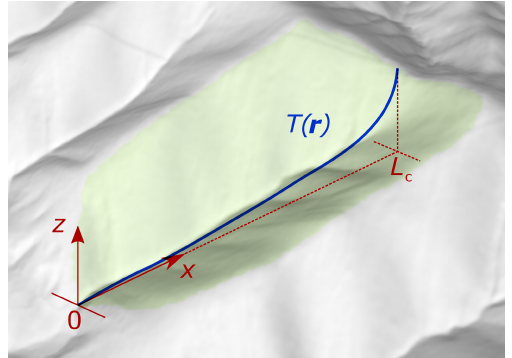
Figure 2. Model context and geometry. Theoretical treatment in the current study is limited to 2D. The model domain is a vertical tran- sect following a stream profile, with vertical axis z and horizontal axis x , spanning a fixed distance from catchment exit at x = 0 to drainage divide at x = L c . The locus of points r along the profile at time t = T , i.e. the surface isochrone, is defined as T ( r ).